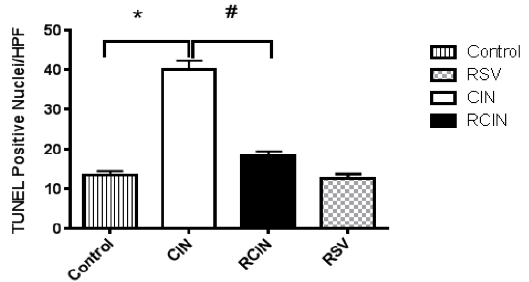
Figure 3. Numeric data of apoptotic renal nuclei are presented. Quantitative analyses of TUNEL-positive cells revealed that pretreatment with resveratrol significantly decreased the number of apoptotic cells by 54.3% in the RCIN group. RSV = resveratrol; CIN = contrast-induced nephropathy; RCIN = resveratrol before contrast-induced nephropathy. All statistical analyses were performed by Kruskal-Wallis test, followed by Dunn’s multiple comparison post hoc test ( n = 8 for each group). *: p < 0.05 versus control; #: p < 0.05 versus RCIN.